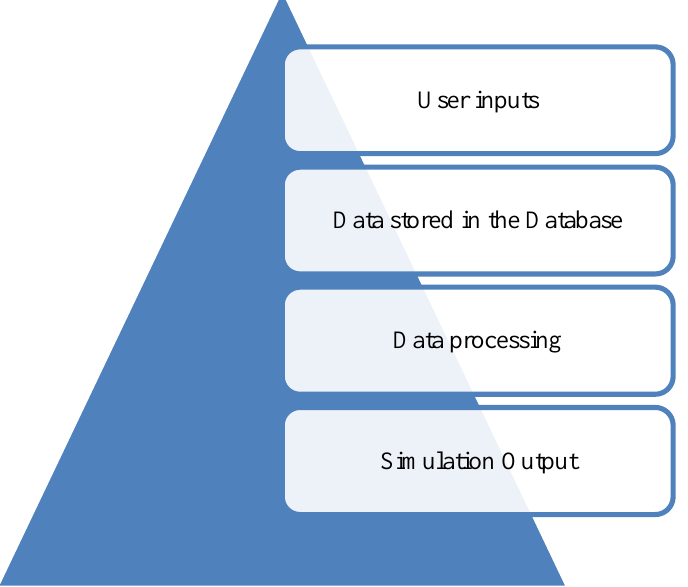
Figure 1. SPECA Model system